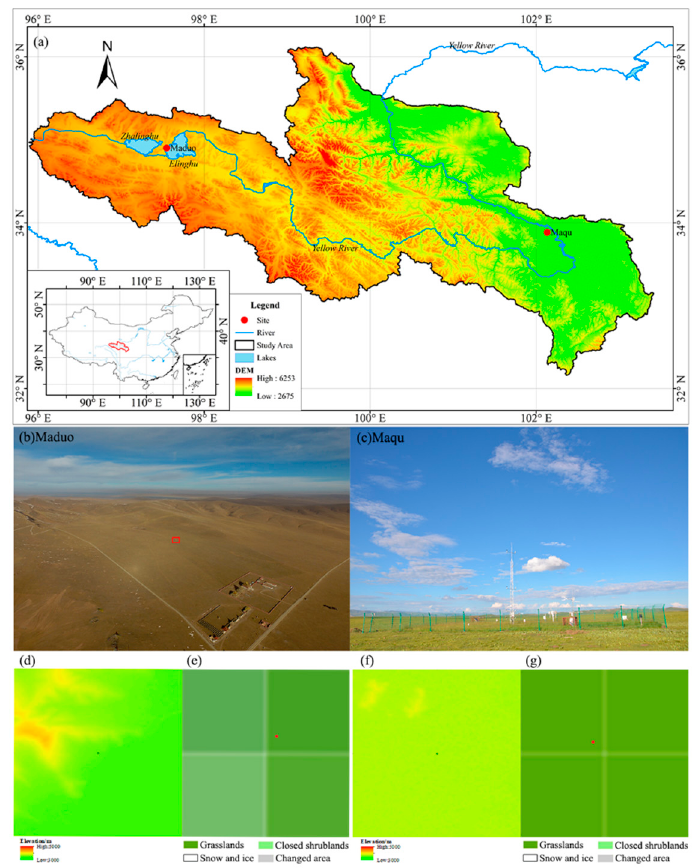
Figure 1. ( a ) Digital elevation map, with the location of the ground measurement sites marked by red circles, setup of the ( b ) Maduo and ( c ) Maqu sites over the alpine meadow, 3 km elevation distribution and vegetation cover types around ( d ) and ( e ) Maduo and ( f ) and ( g ) Maqu sites, respectively.